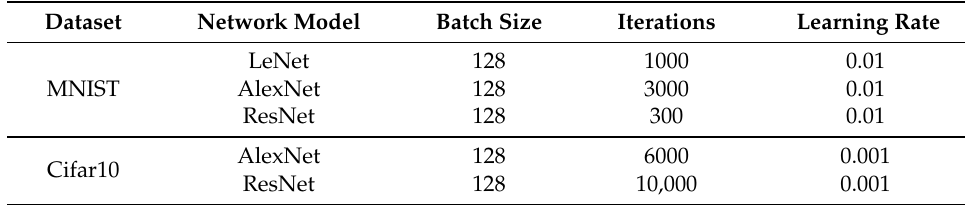
Table 1. Parameter information in